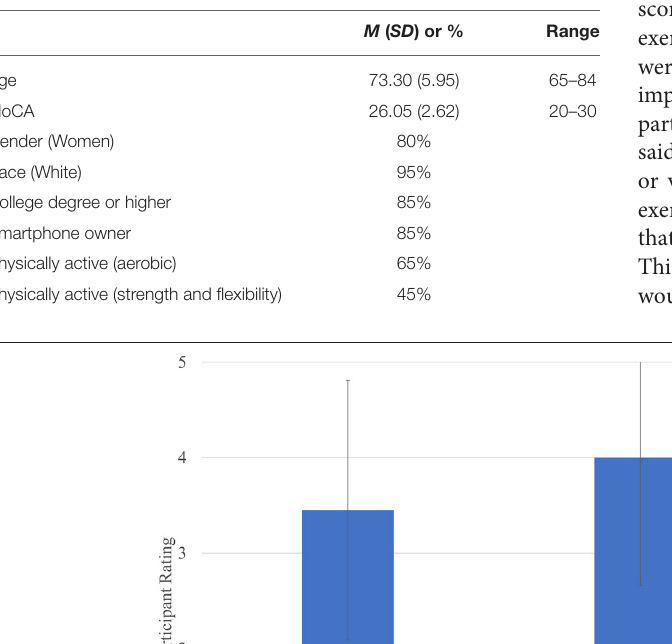
TABLE 1 | Demographics of study sample ( N = 20).